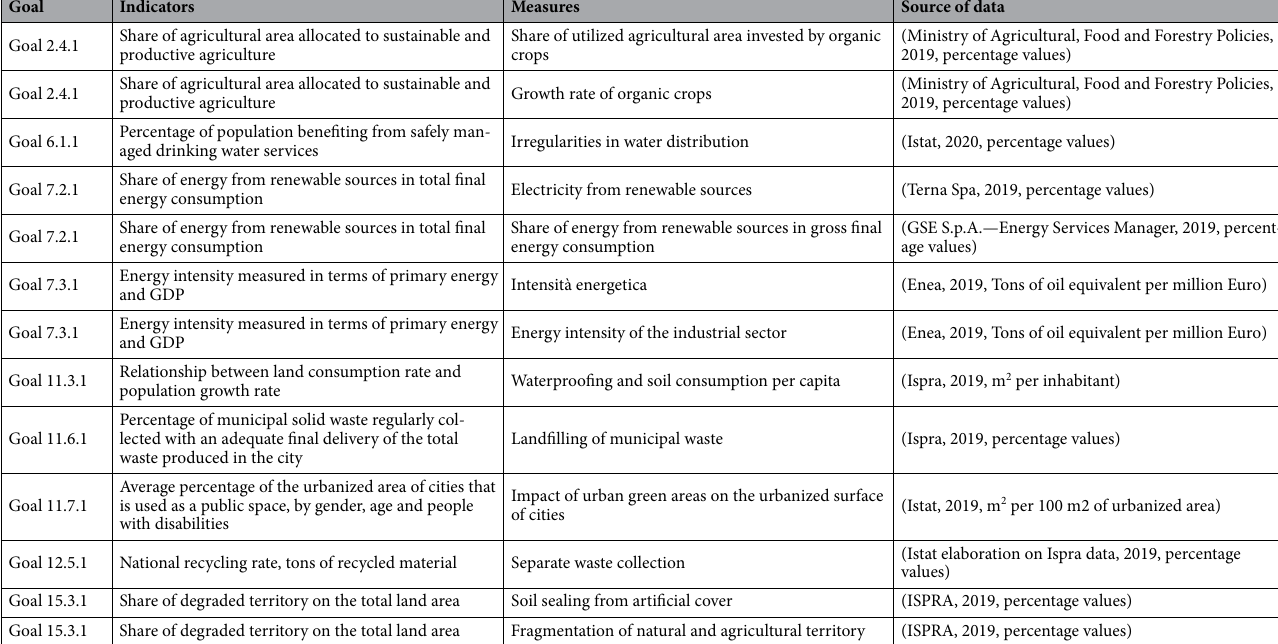
Table 1. Goal, indicators, measures e source of SDGs data. Source : our elaboration on